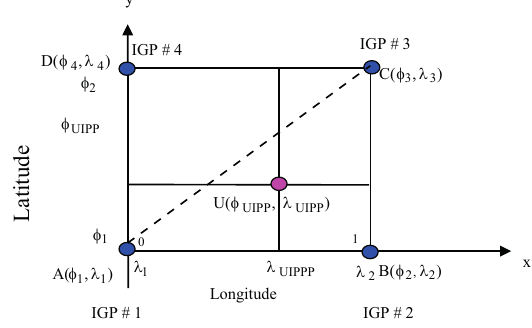
Fig. 1. User IPP location in square cell with four